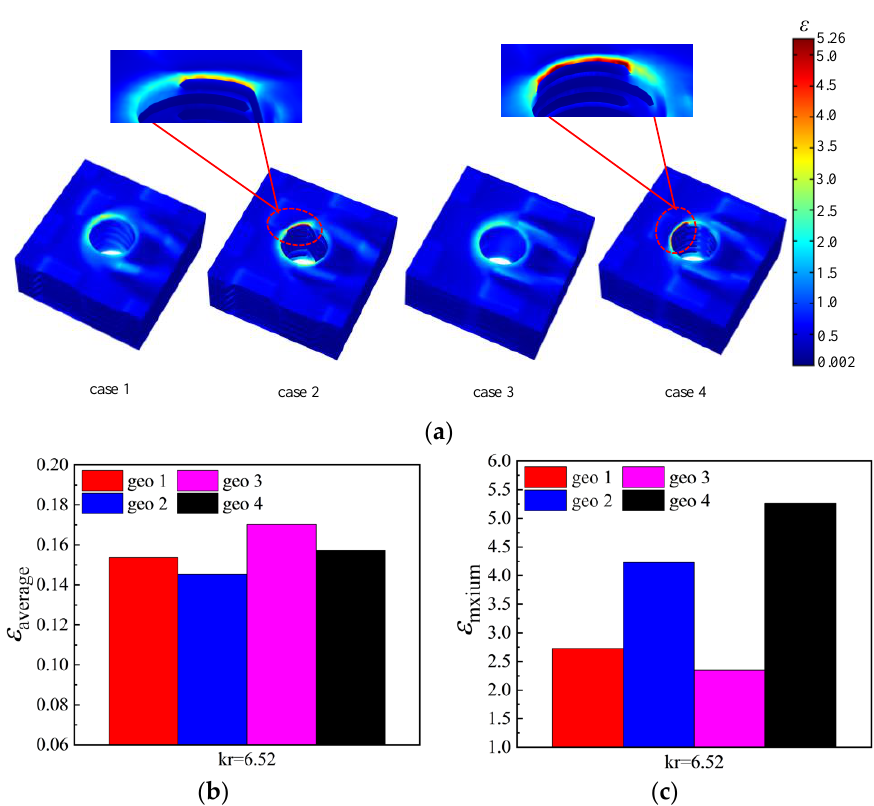
Figure 14. The thermal gradient of cases 1 – 4 on CCR: ( a ) thermal gradient of cases 1 – 4, ( b ) average relative temperature gradient, and ( c ) maximum relative temperature gradient.